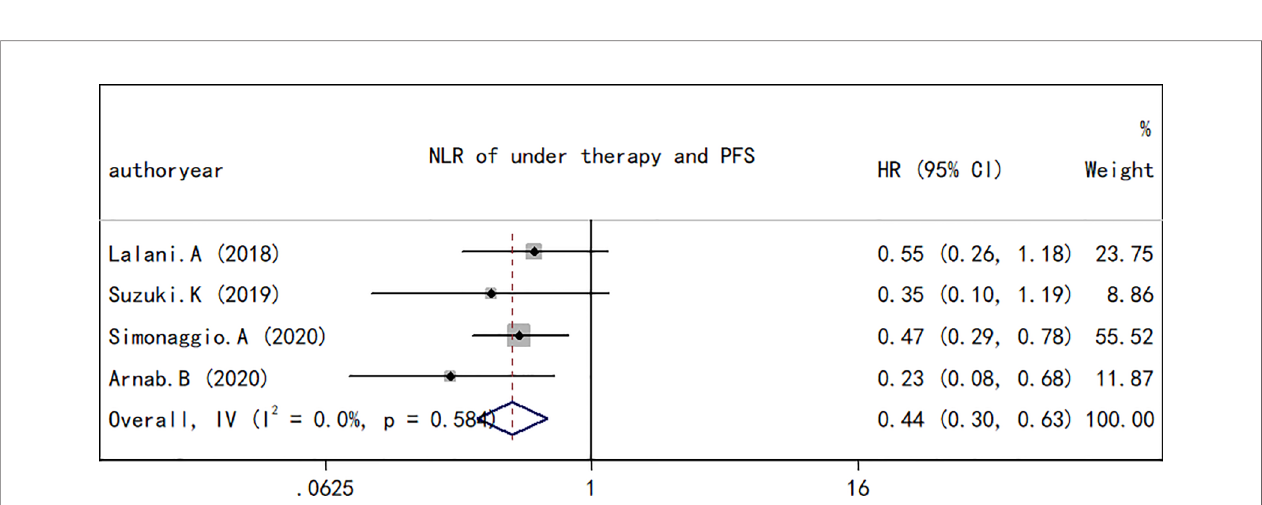
FIGURE 5 | Forest plot of hazard ratios for the association between the neutrophil-to-lymphocyte ratio under therapy and progression-free survival in renal cell